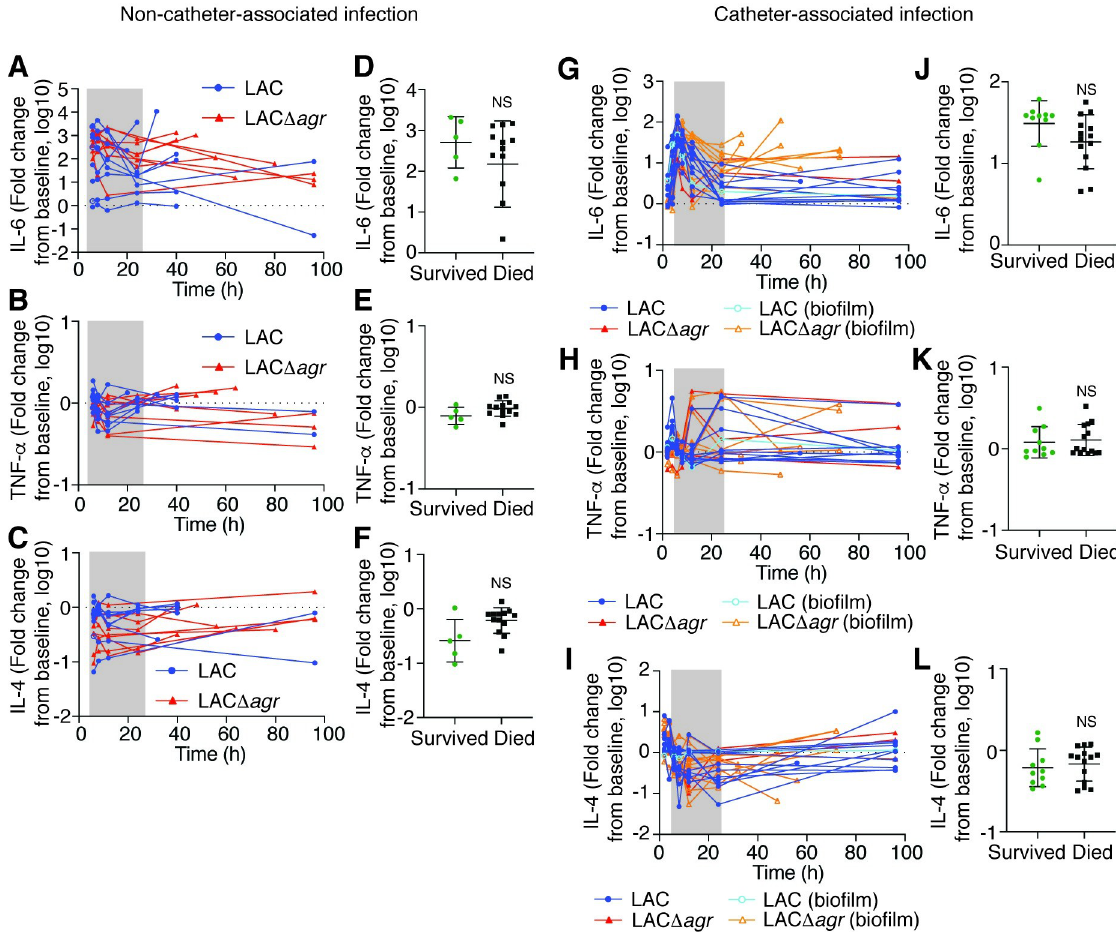
Fig 6. Rabbit sepsis model–cytokine levels. ( A - C ) Fold-changes of the indicated cytokines over time in the non-catheter-associated model. ( D - F ) Analysis of death versus survival outcome based on average cytokine fold-changes in the time window 6–24 h (grey shading) in panels A-C. ( G - I ) Fold-changes of the indicated cytokines over time in the catheter-associated model. ( J - L ) Analysis of death versus survival outcome based on average cytokine fold-changes in the time window 6–24 h (grey shading) in panels G-I. ( D - F , J - L ) Statistical analysis is by unpaired two-tailed t-tests. Error bars show the geometric mean and geometric SD. NS, not significant (p � 0.05). See S3 Fig for the corresponding analysis of Agr status for both rabbit models.